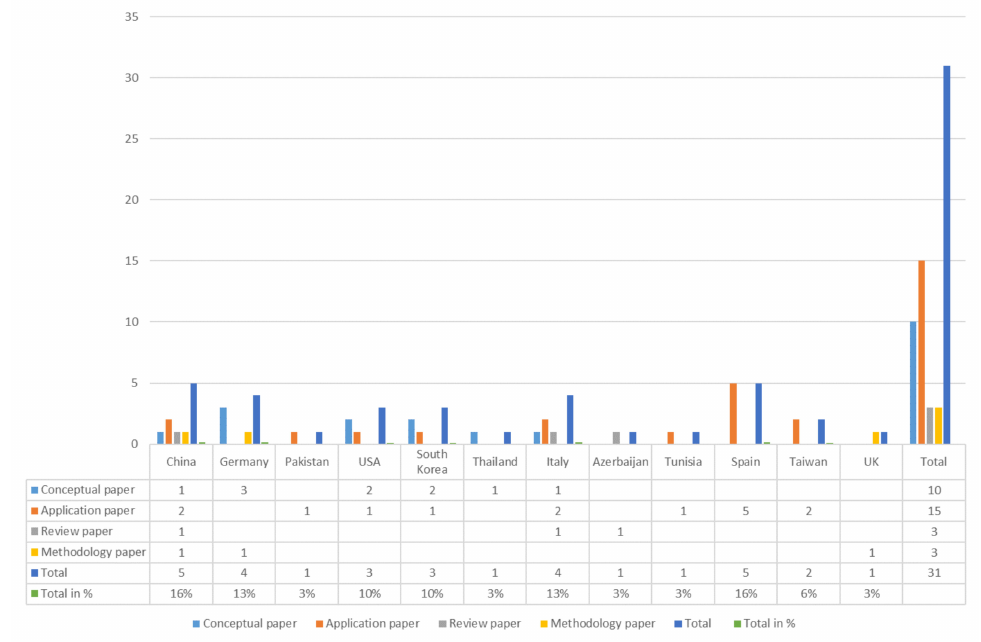
Figure 5. Classification of the type of papers as a function of the geographic distribution (source: